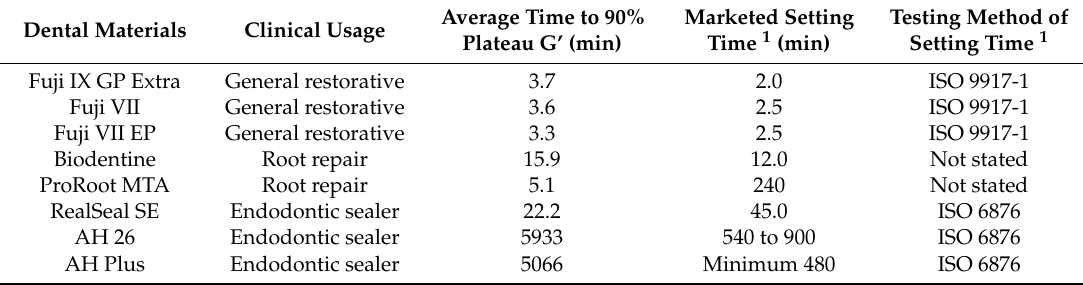
Table 3. Comparison of marketed setting times against proposed setting times using the time to reach 90% of the plateau elastic